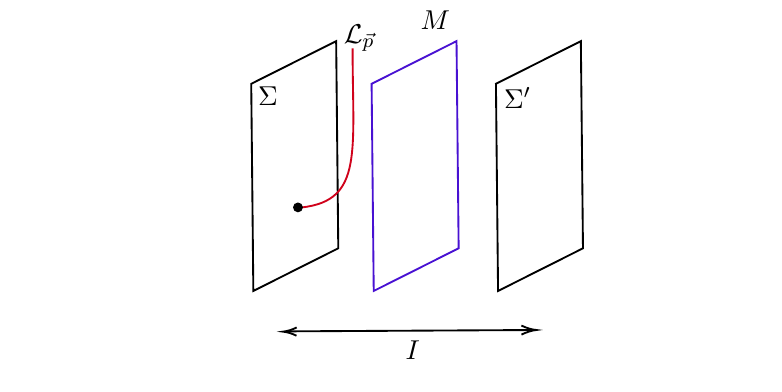
Figure 2 . The endpoint of L ~p on Σ gives a defect endpoint operator corresponding to a state in the defect Hilbert space, H Defect . We can think of L as generating a 3d 1-form symmetry or a 2d ~p L ~p 0-form symmetry (when L is pushed to lie completely on Σ ~p